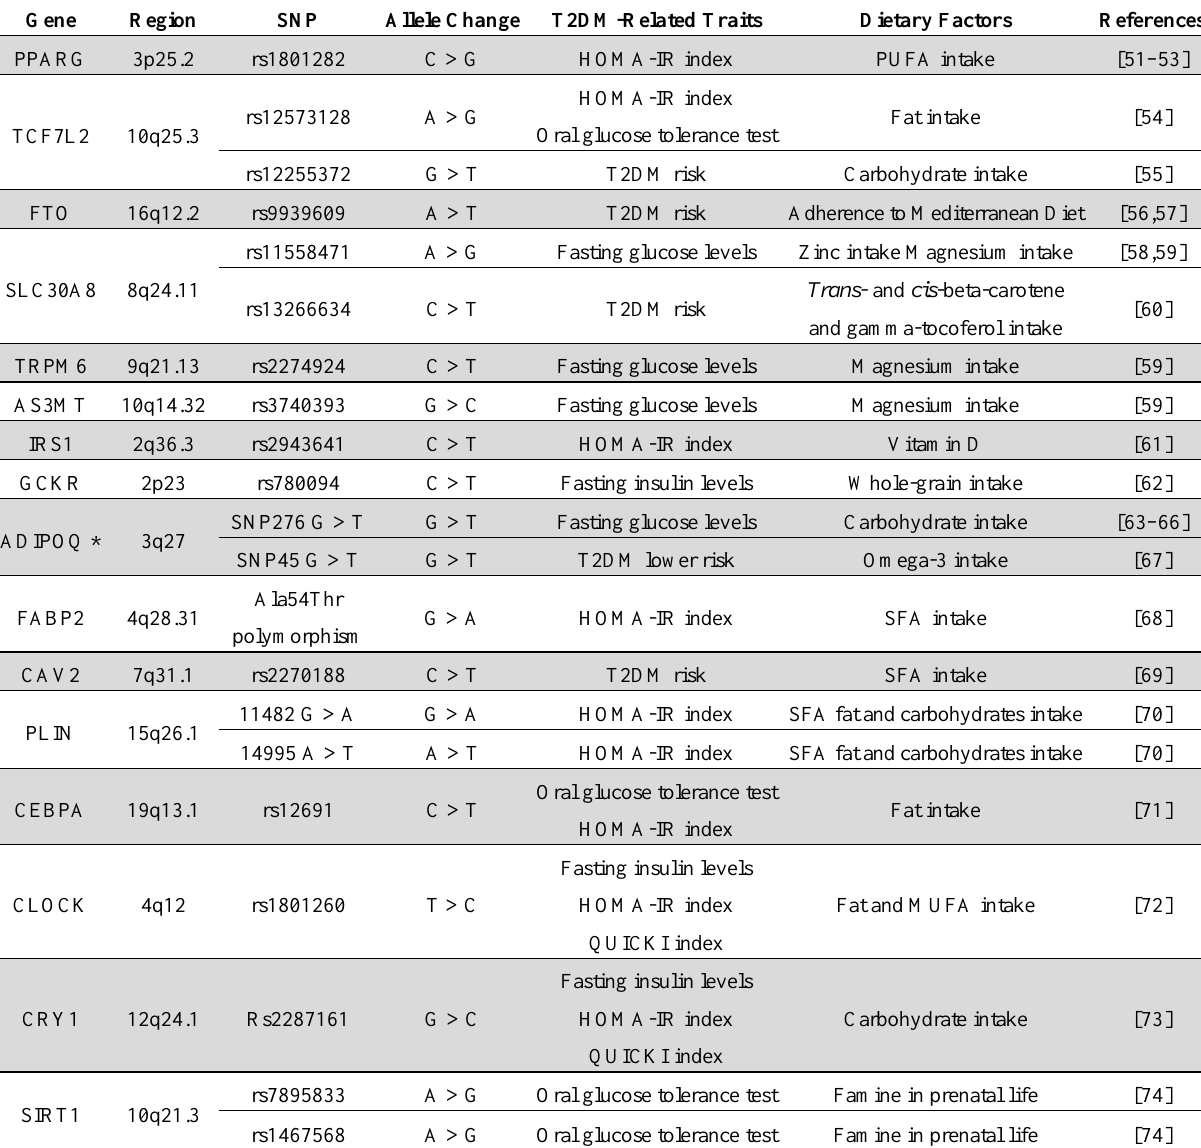
Table 2. Gene-nutrient or -dietary pattern interactions in the development of